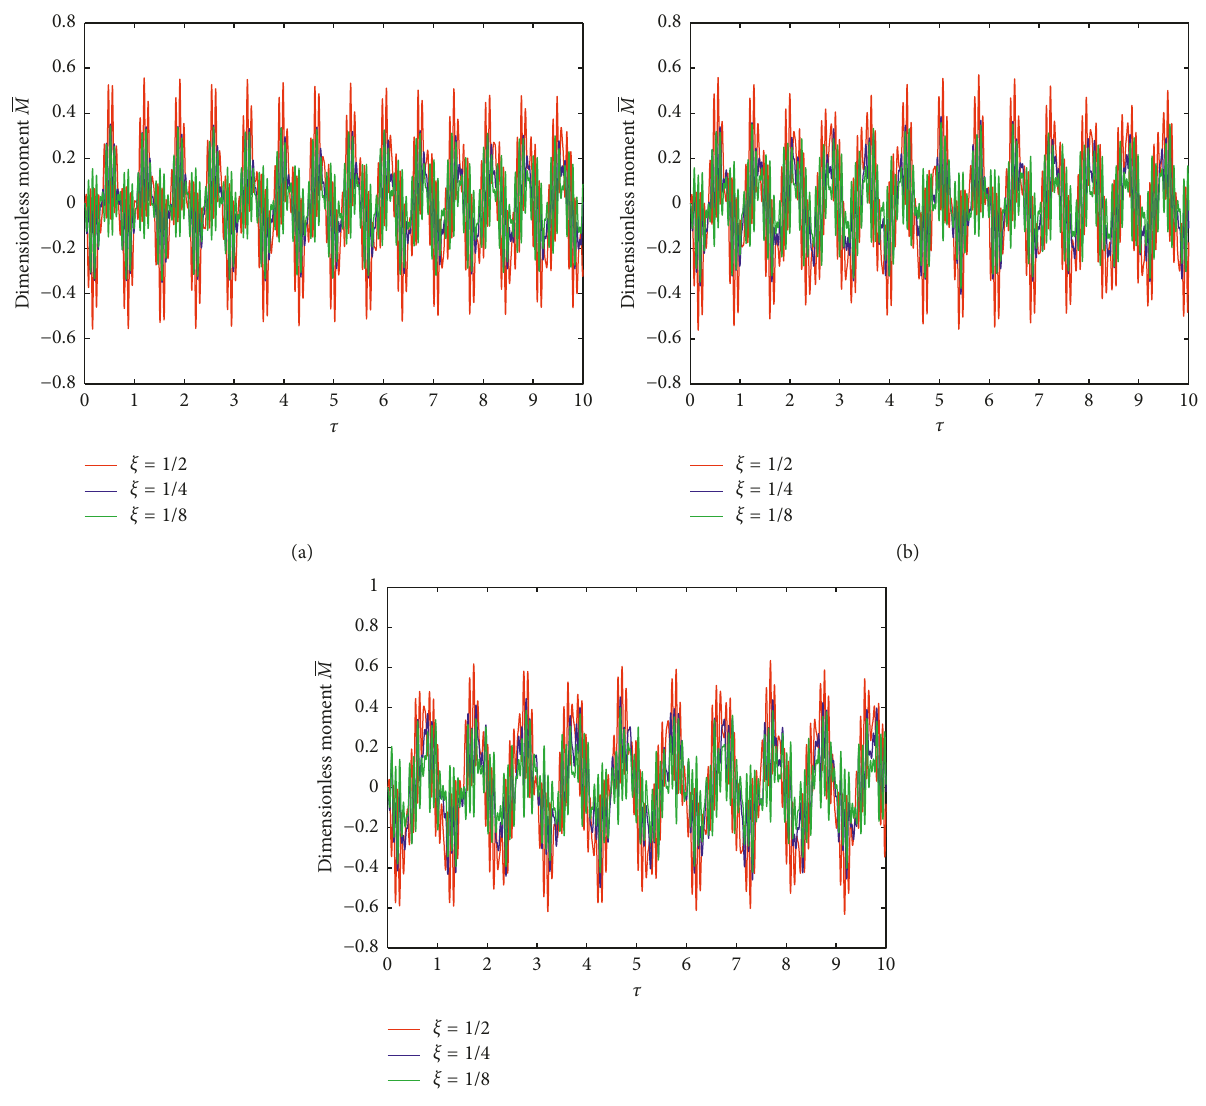
Figure 10: History curves of bending moment on the pinned-pinned pipe at different locations and having different fluid velocities: (a) u � 0; (b) u � 1; (c) u � 2.